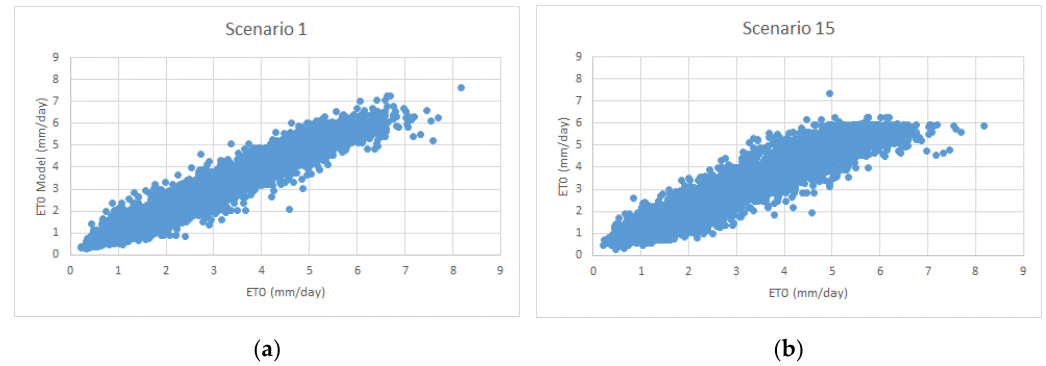
Figure 8. Scatter plot of REPTree method for ( a ) Scenario 1 and ( b ) Scenario 15.